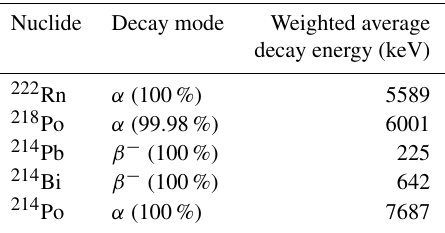
Table 1. Decay modes and energy of 222 Rn and its short-lived progeny taken into account in the ionising capacity determination. Decay partitioning is accounted in defining the weighted average decay energy. The data are extracted from the National Nuclear Data Centre of Brookhaven National Laboratory (http://www.nndc. bnl.gov/chart/).